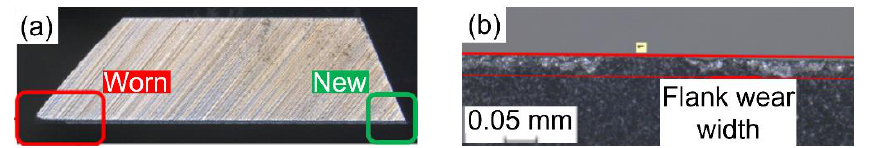
Figure 2. ( a ) Comparison of CER between a worn and a new cutting edge; ( b ) Flank wear on a PCD tool.